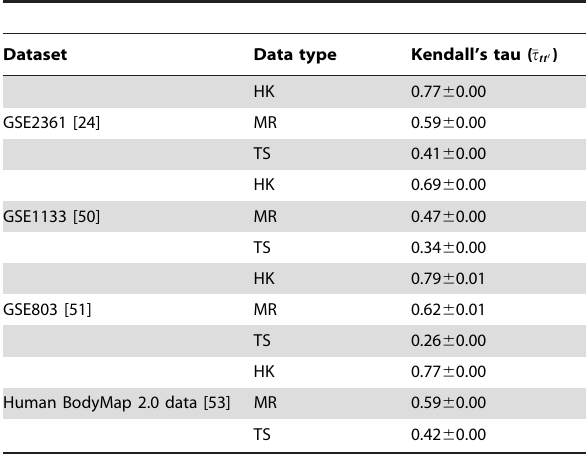
Table 1. Kendall’s tau computed for the HK, MR, and TS genes, for four